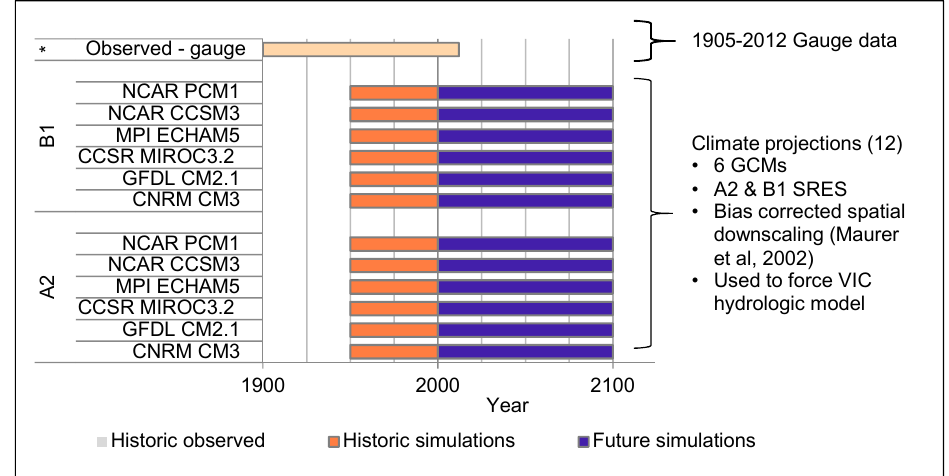
Figure 6. Observed and modeled daily streamflow used for historic (orange) and future (indigo) flood frequency analysis on the American River at Folsom.